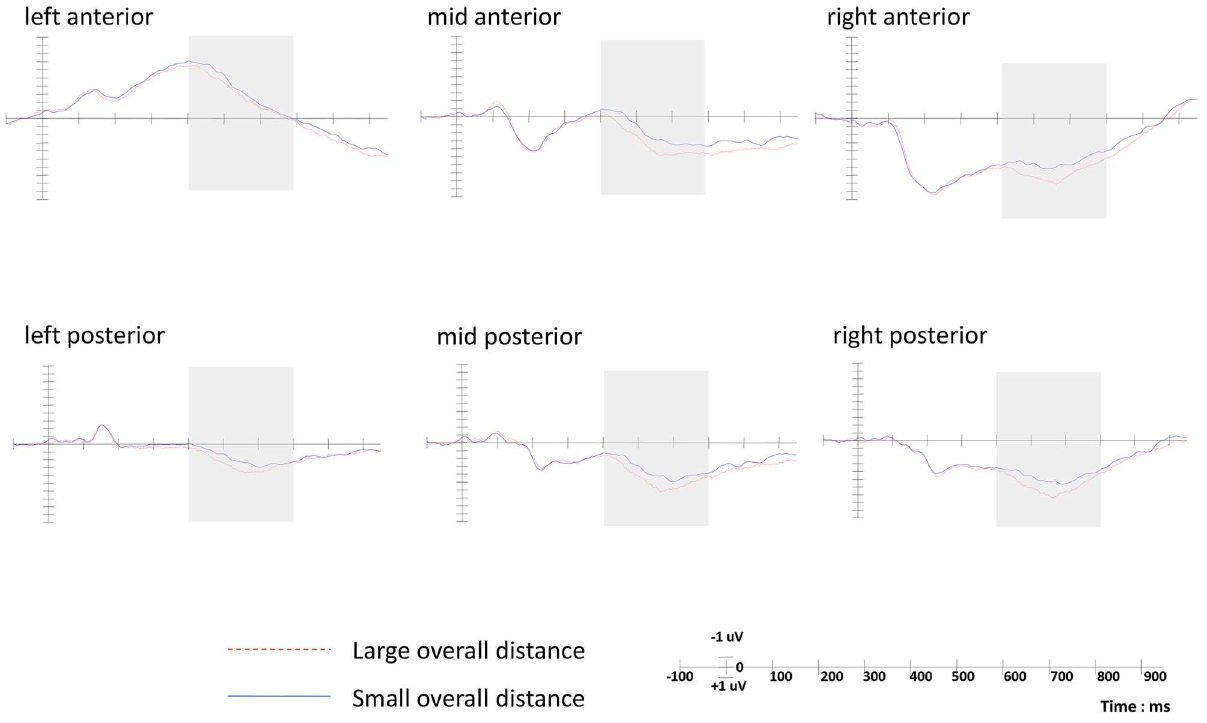
Fig 6. Grand average ERPs at six ROIs in Experiment 2 (400–700ms). The origin of the time-axis (0ms) is placedat the onset of the target word, ERPs elicited in the large overalldistance condition(dotted line) were significantly more positive than the small overall distance condition(solid line) in the 400- to 700-ms interval after third word onset across six ROIs (light grey